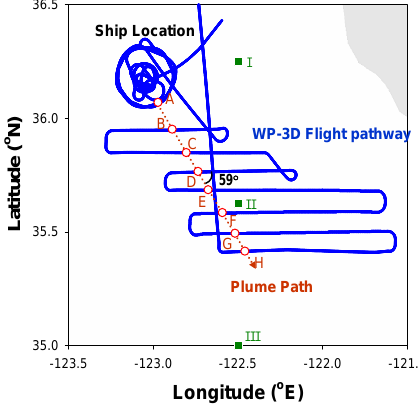
Fig. 2. Eight ship-plume transects (A–H) made by NOAA WP-3D flight near the California coast (Chen et al., 2005). I, II, and III de- note three locations where the NCEP reanalysis data were